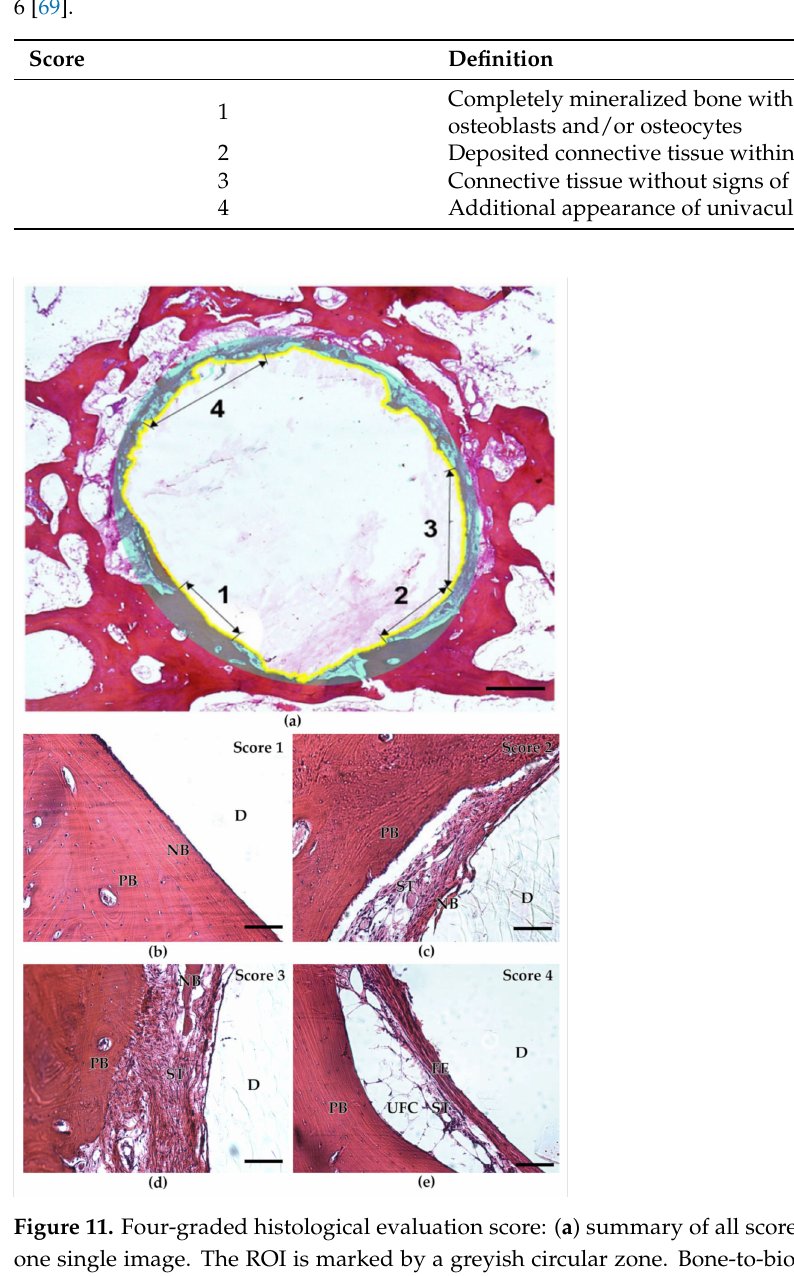
Table 2. Four-graded histological evaluation score adapted and modified from DIN EN ISO 10993-